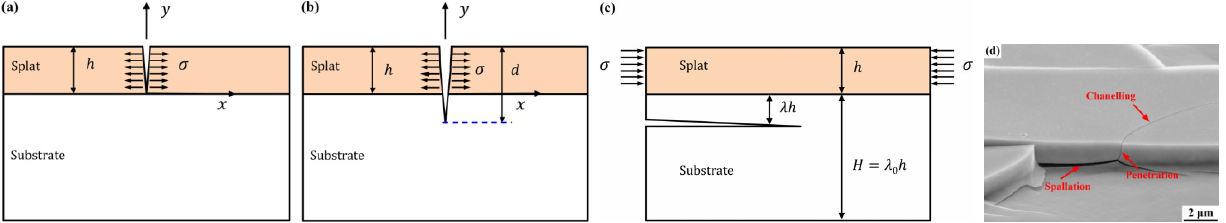
Fig. 7 Schematic diagram of the failure mode of (a) channel cracking, (b) substrate penetration, and (c) substrate spallation, where h , H , d ,  h , and  represented splat thickness, substrate thickness, penetration depth, spallation depth, and stress, respectively. (d) Typical image for the three failure